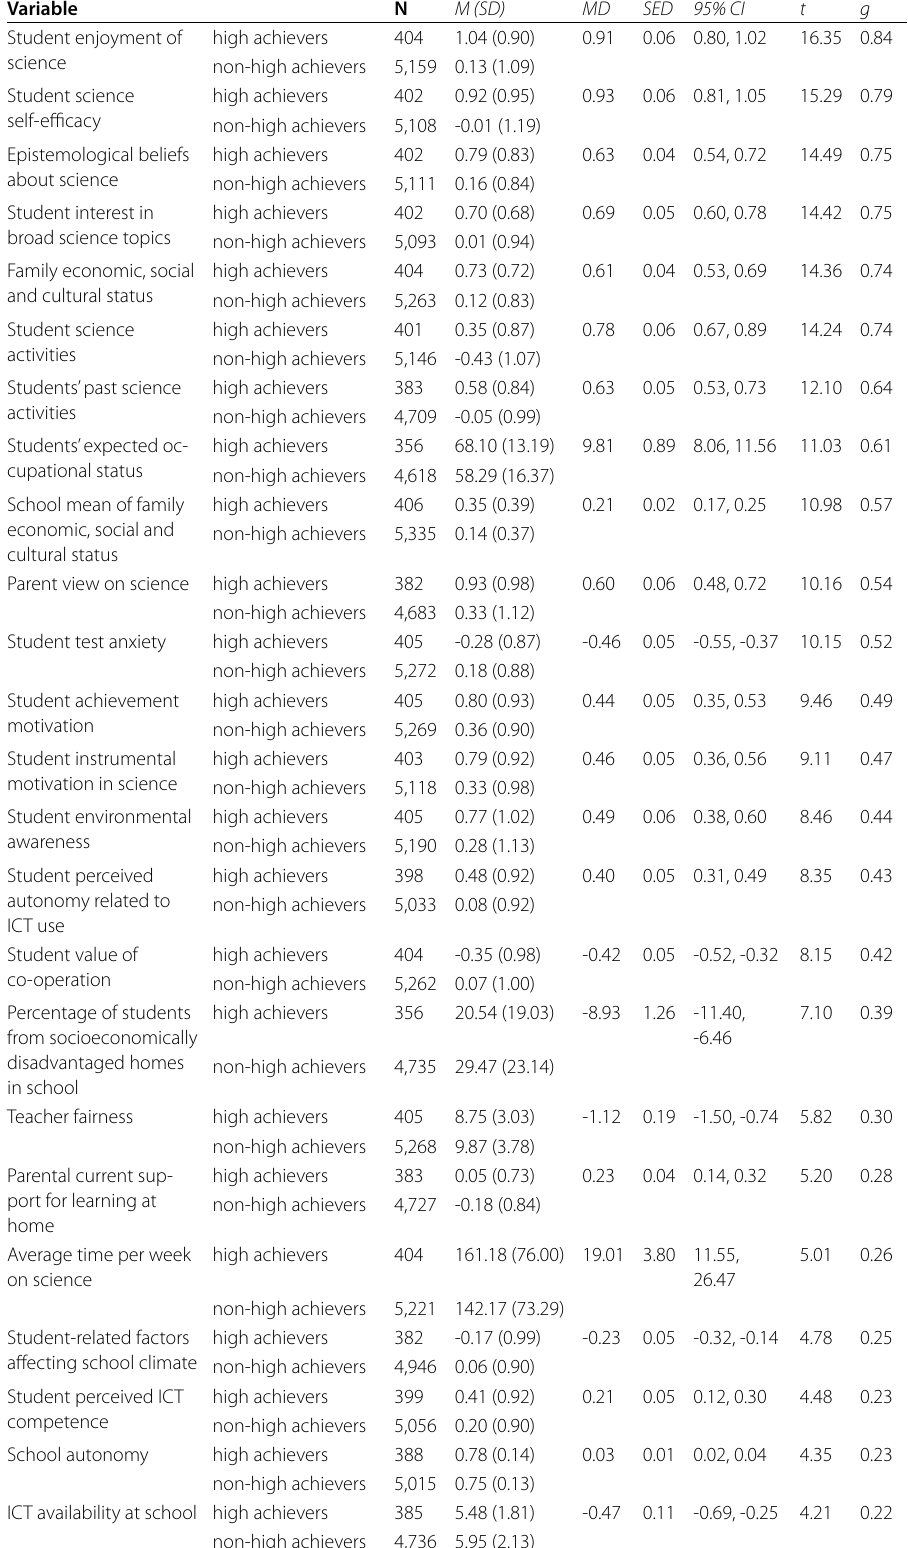
Table 4 Means in continuous background variables by science performance group, PISA